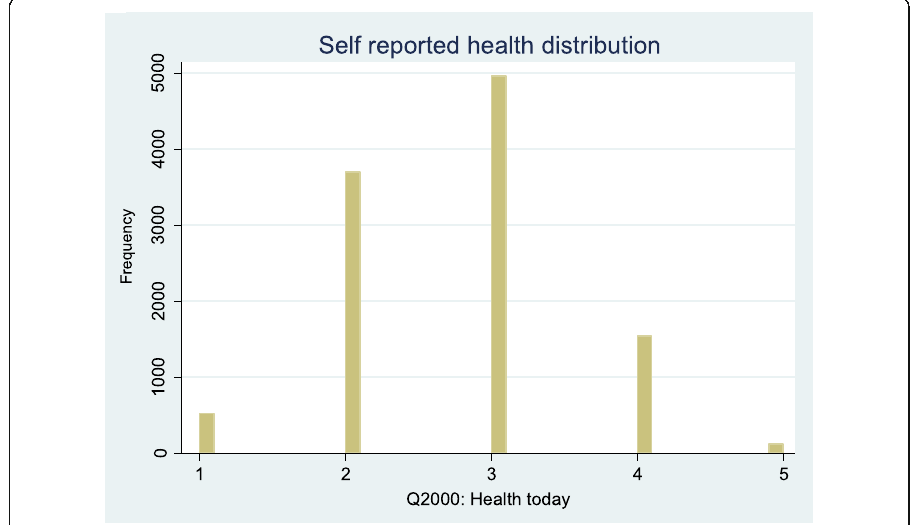
Fig. 1 Distribution of self-reported health response. Note :SAH is on a 1-5 scale , where 1=very good; 5=very